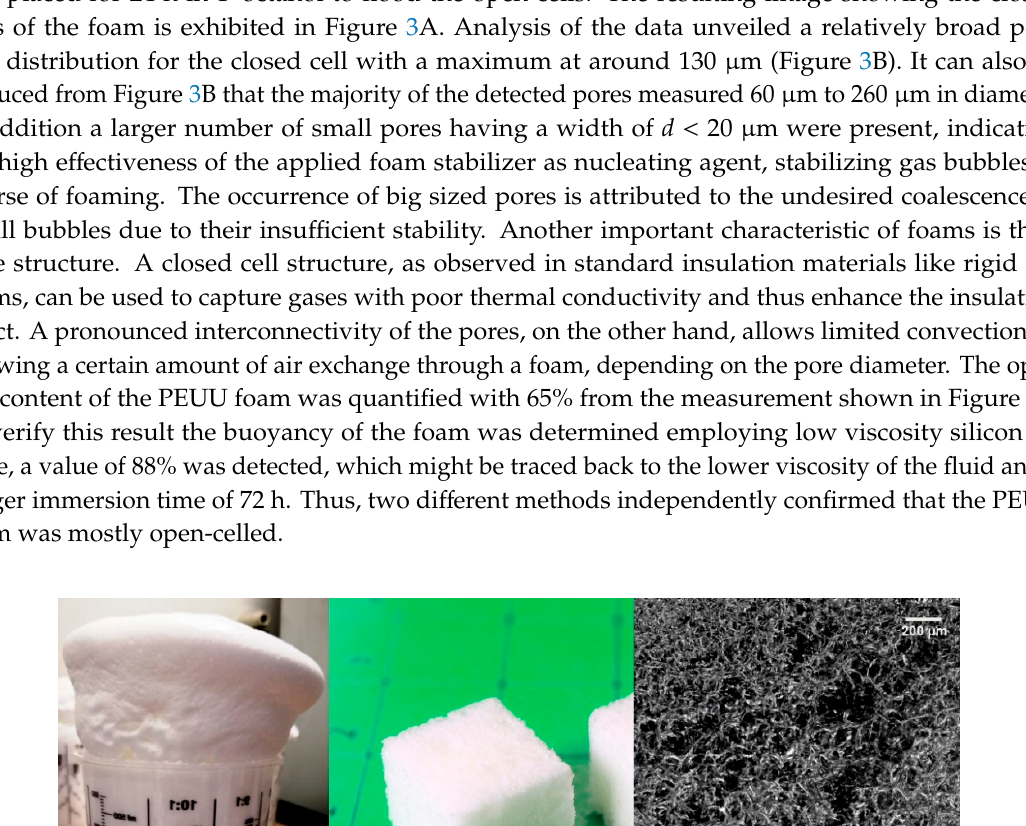
Figure 2. Polyester urethane urea foam: As synthesized ( A ), cube-shaped samples as used for mechanical and thermomechanical characterization ( B ) and µCT image of the foam ( C ).